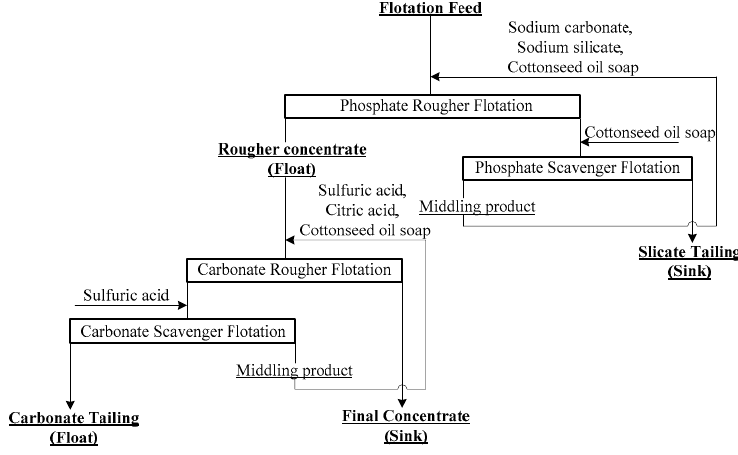
Figure 7. Closed circuit flotation experiment for the removal of silicates and carbonates.